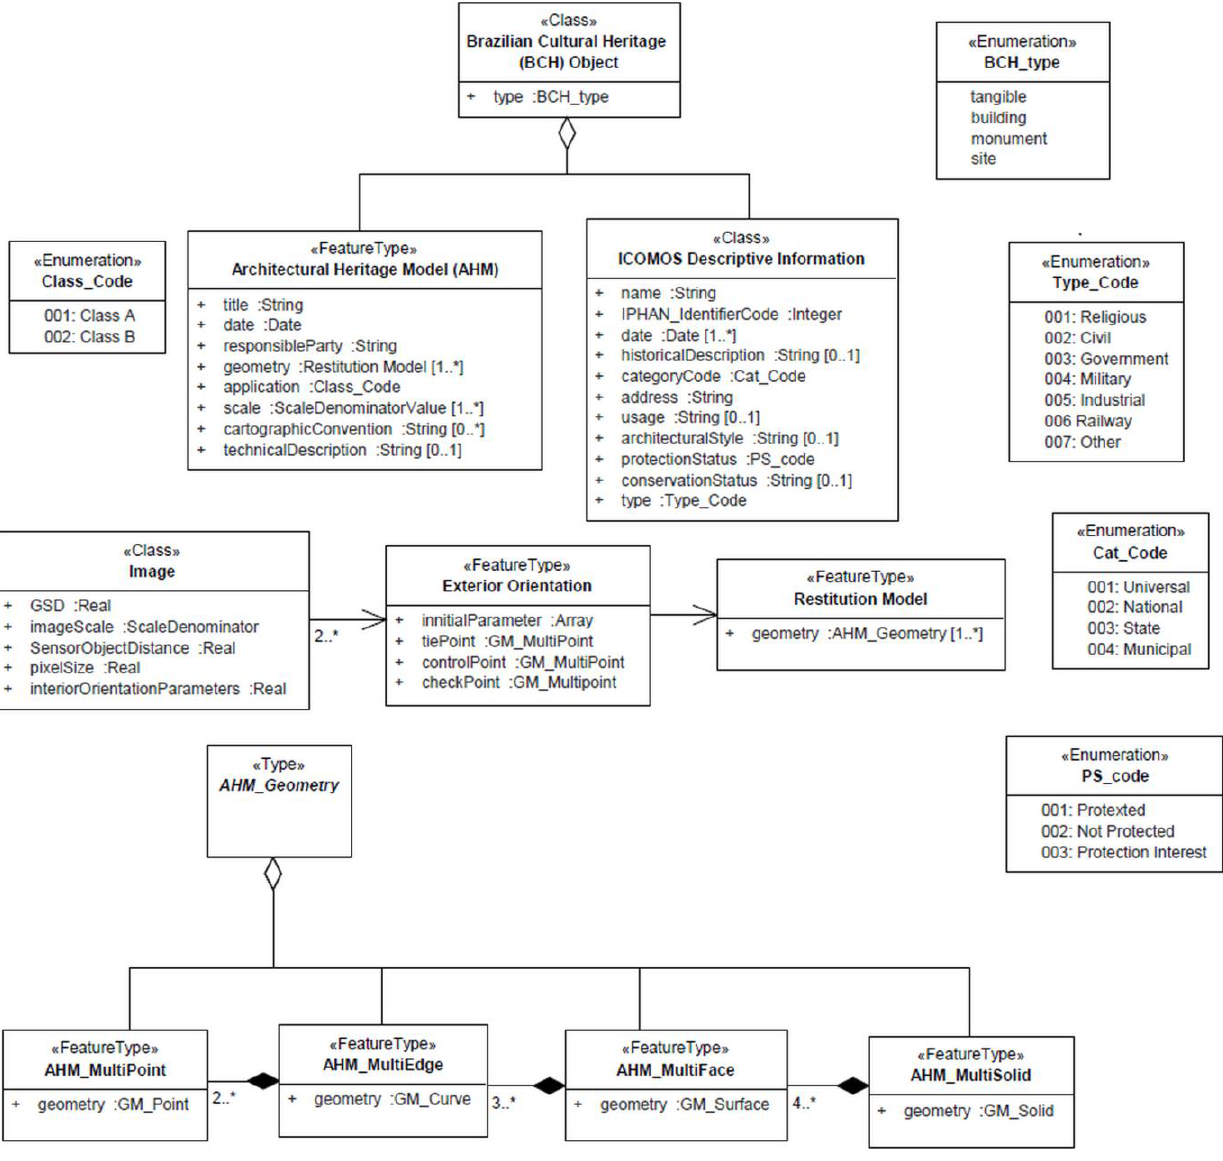
Figure 1. Brazilian cultural heritage documentation-content and